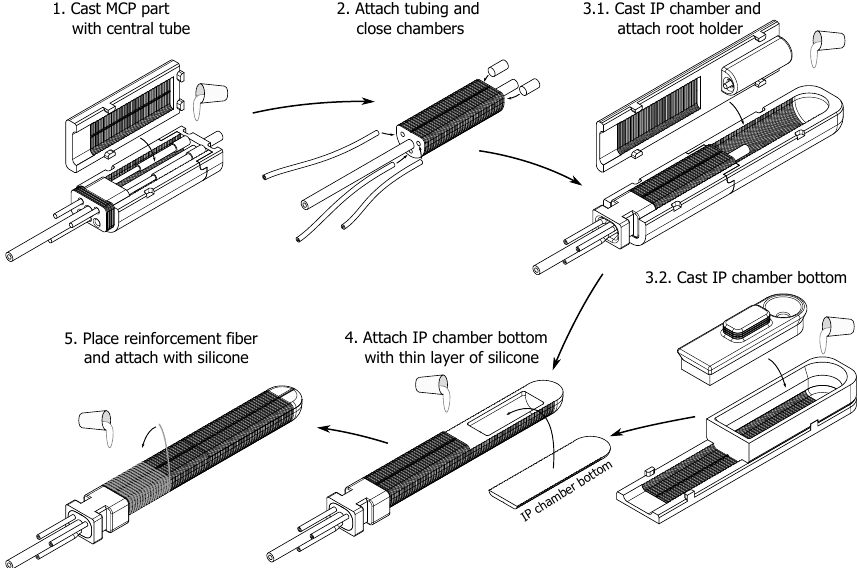
Figure 3. Actuator fabrication flow. (1) The MCP part is cast first; and (2) input tubing is attached to it. Abduction-adduction chambers are plugged with pieces of 4-mm tubing, and the flexion chamber is closed with glue. (3.1) The MCP part is placed in the mold, and the IP chamber’s top is cast to merge with it. The root holder can also be attached at this point. (3.2) The IP chamber’s bottom is cast simultaneously with the IP chamber, in a separate mold. (4) The 2-mm thick IP chamber bottom is then attached to close the chamber. (5) Finally, reinforcements are placed on the actuator in the wanted layout and attached with a thin layer of